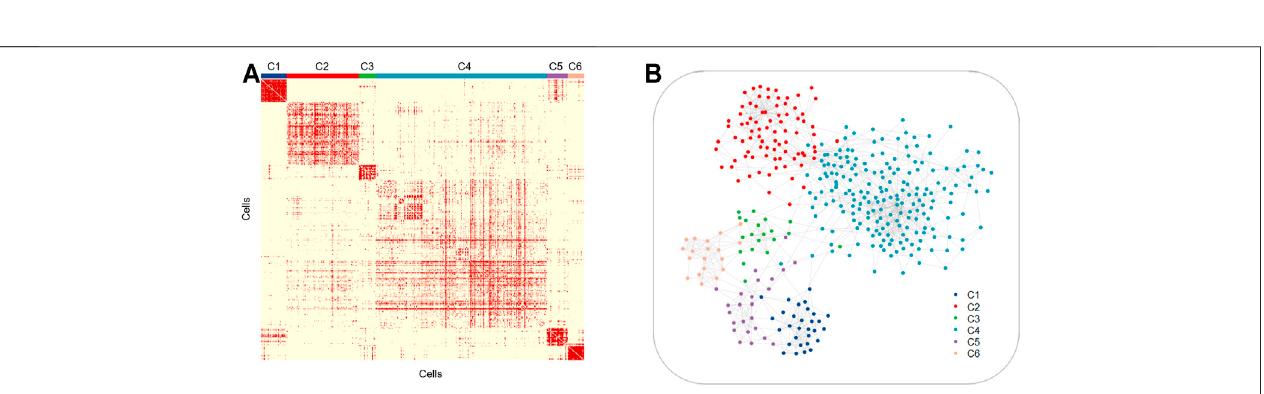
FIGURE 7 | Similarities of the six colorectal tumor cell clusters. Similarity matrix (A) and cell network (B) for 375 colorectal tumor cells illustrating the tightness of connectivity within clusters.